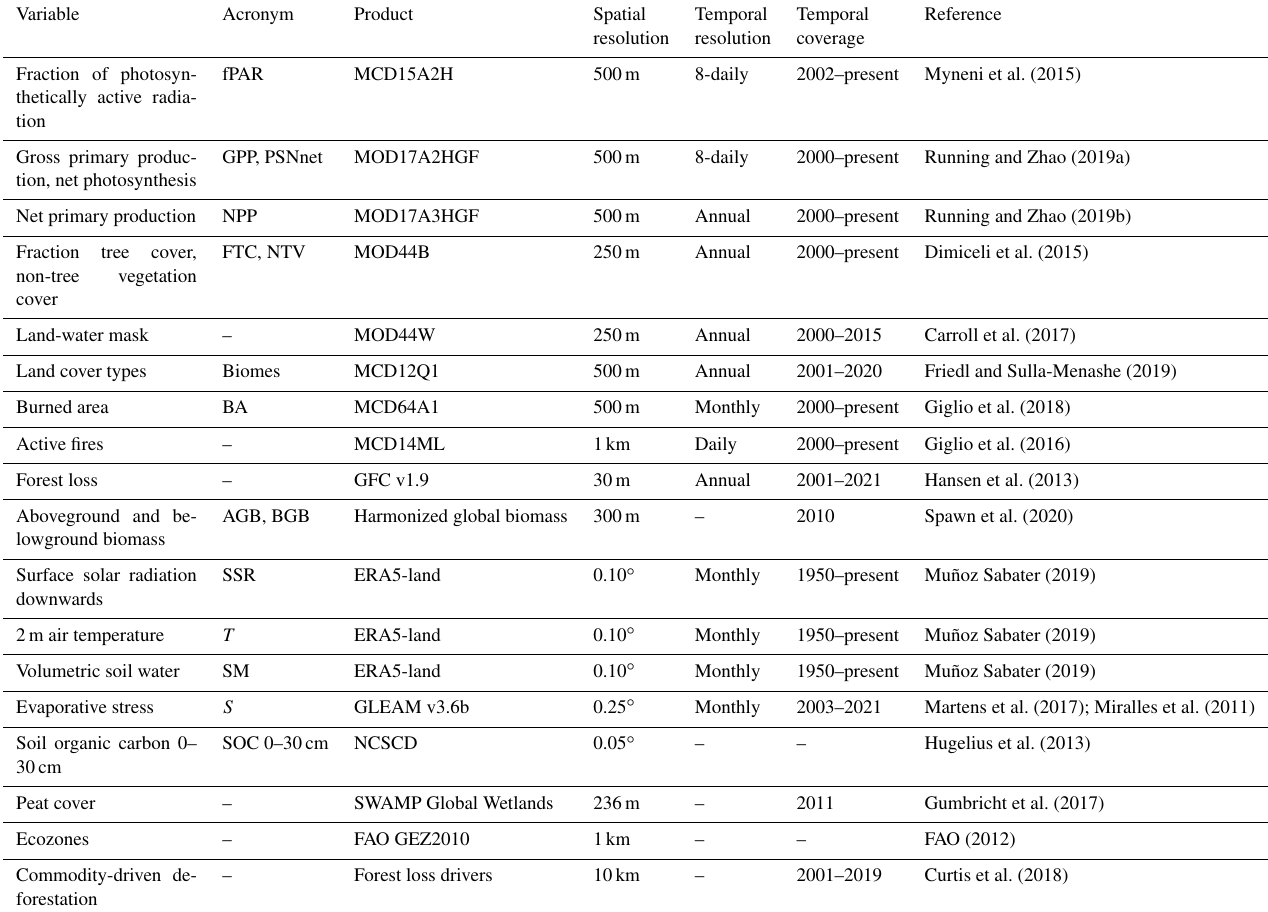
Table 1. Overview of datasets used as input for the global